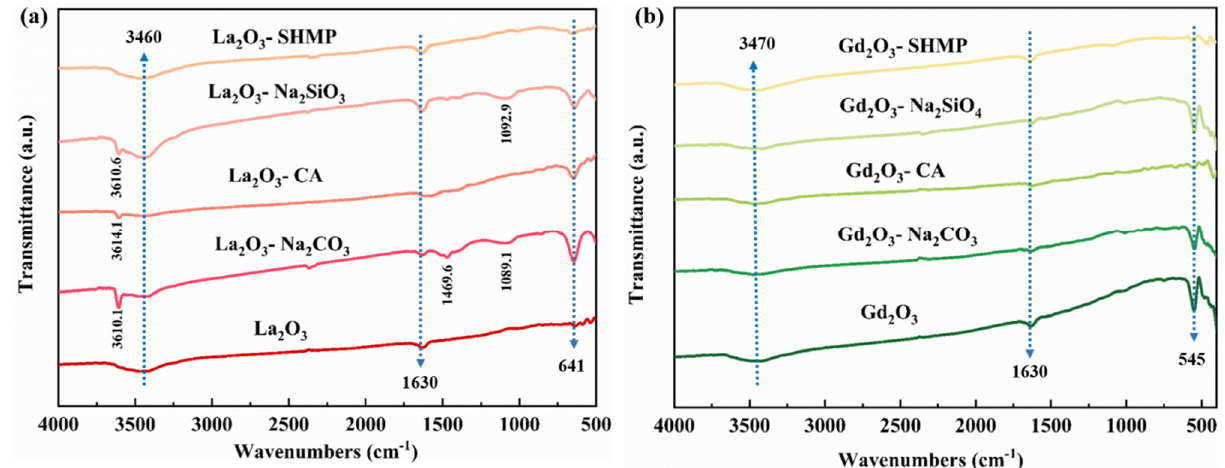
Figure 8. FTIR spectra of oxide particles before and after four different dispersants, ( a ) La 2 O 3 and ( b ) Gd 2 O 3 .